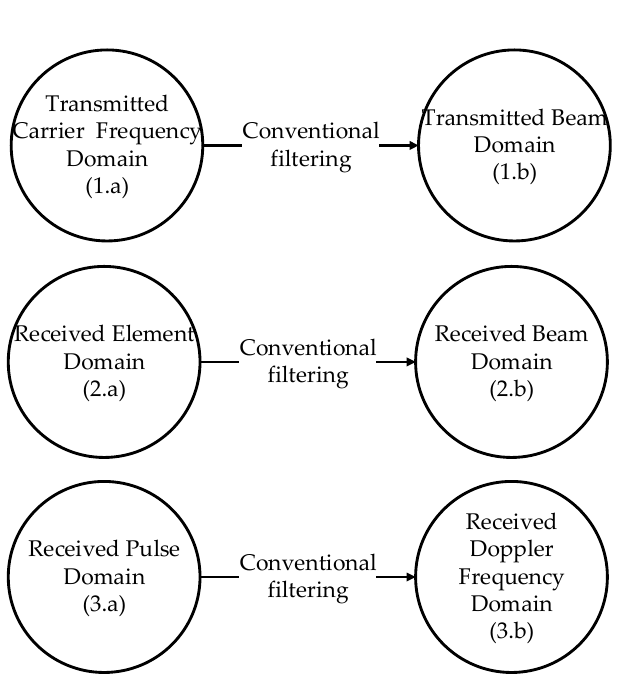
Figure 3. Multi-domain signal processing architecture.